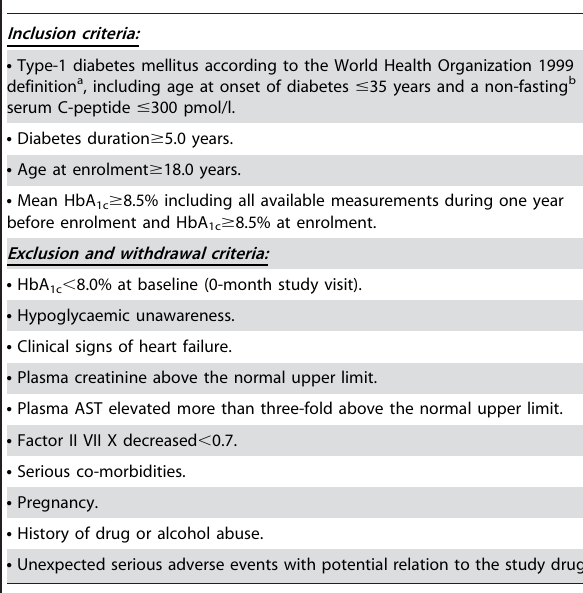
Table 1. Inclusion, exclusion and withdrawal